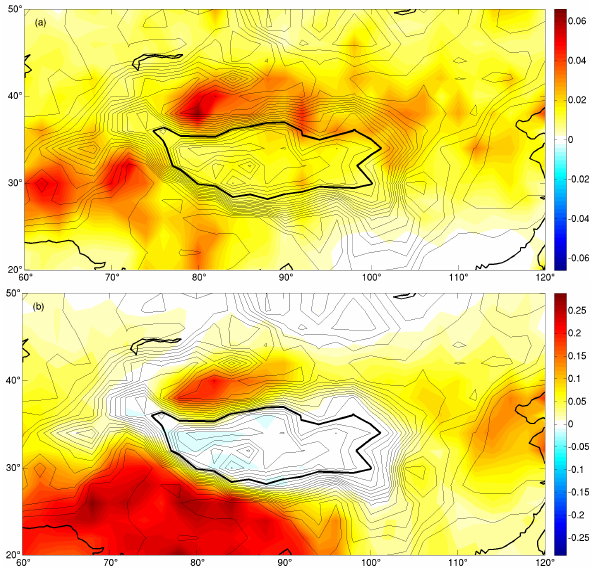
Fig. 9. Vertically averaged SW heating rate anomalies due to aerosols between (a) 5 and 8km and (b) 0 and 5kma.m.s.l. in K/day. Simulation with MODIS surface albedo. Note the different scalings of the colorbars, each time adjusted to the respective ex- treme value. The thick lines indicate coasts and the Tibetan Plateau.